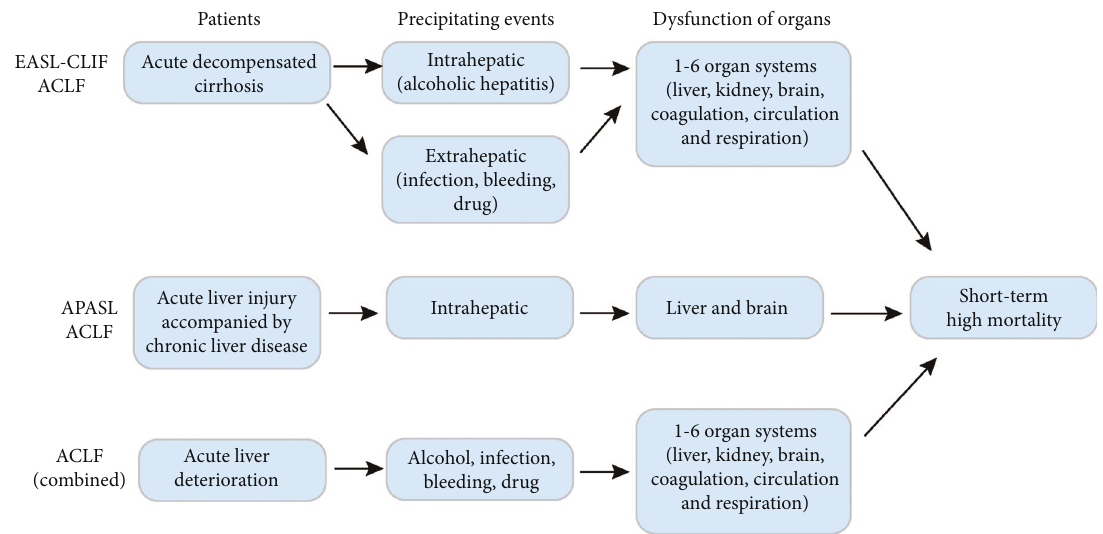
Figure 1: The clinical features of ACLF. Combining the de fi nitions of EASL-CLIF ACLF and APASL ACLF, we de fi ned ACLF as a syndrome of acute liver deterioration induced by precipitating events in patients with cirrhosis or noncirrhotic chronic liver disease, leading to failure of two or more organs, accompanied by short-term high